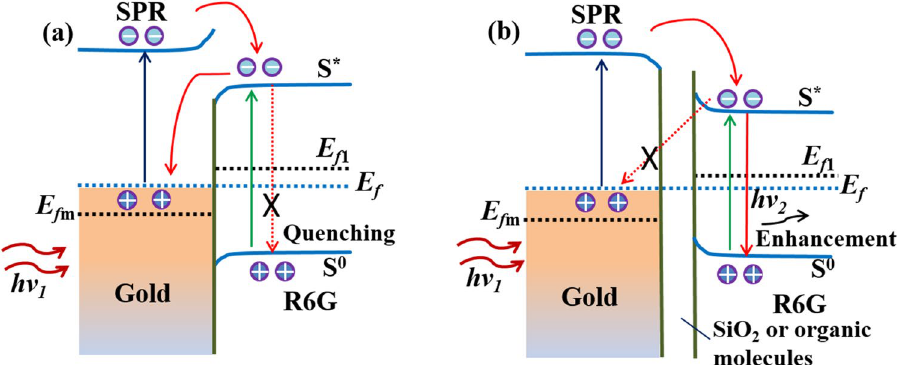
Figure 9. Schematic diagram of the surface resonance charge transfer. ( a ) The fluorescence dye R6G having close contact with Gold. ( b ) The fluorescence dye R6G and Gold was isolated by SiO 2 or organic molecules. (Xmeans the drop process was